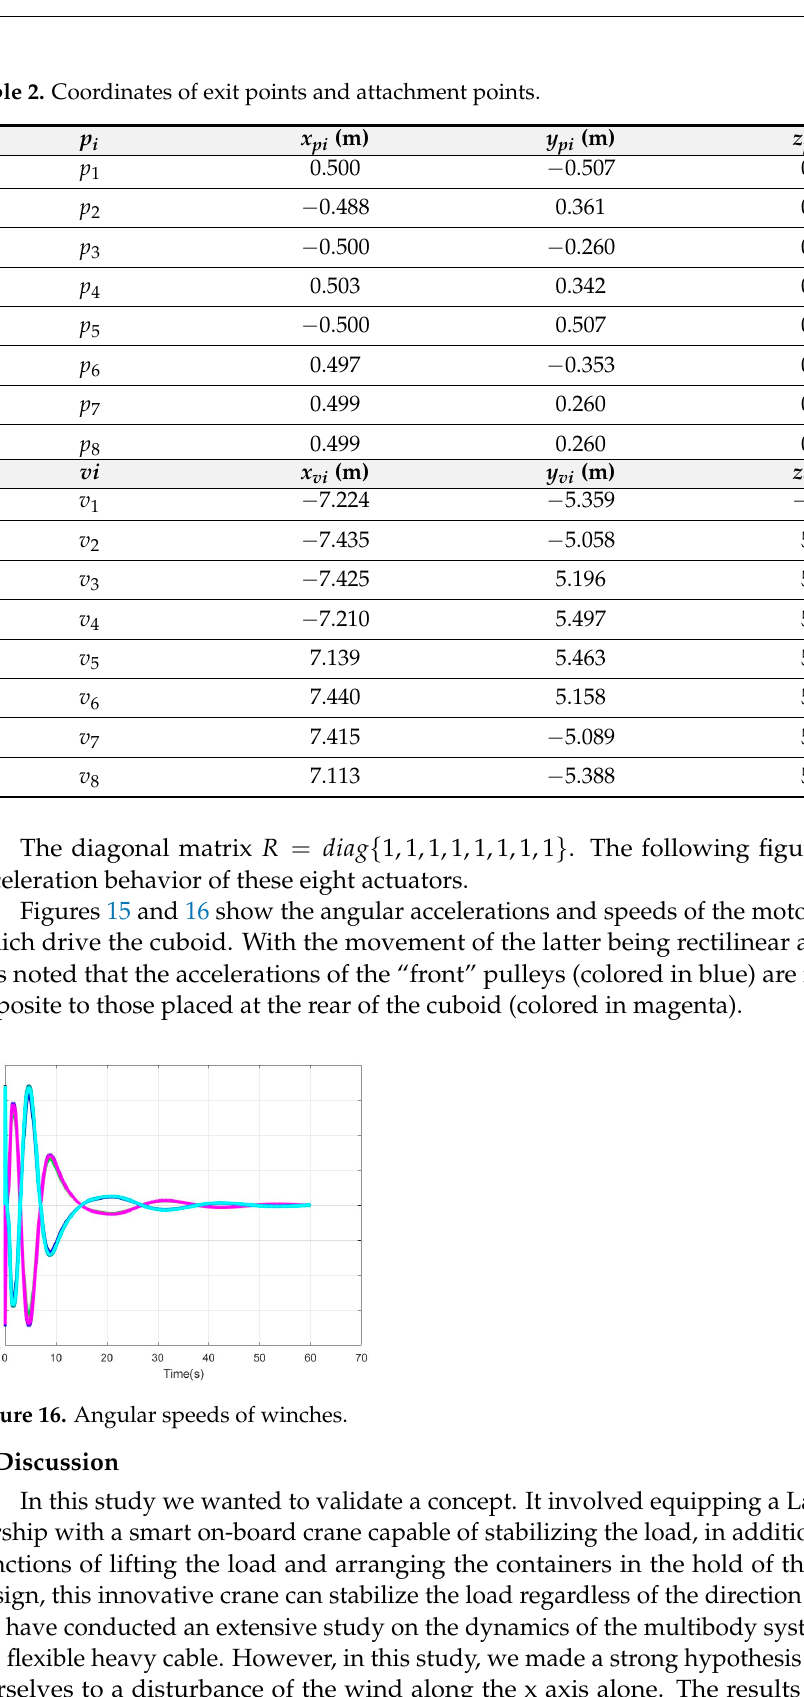
Table 2. Coordinates of exit points and attachment points.